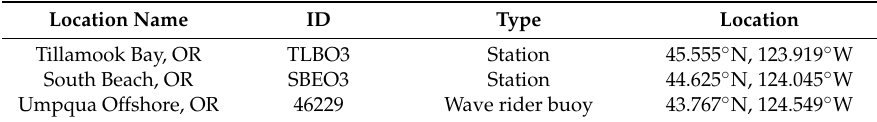
Table 3. The location name, ID, type, and geographical location of NOAA National Center Data National Data Buoy Center (NDBC) stations and buoys used in the